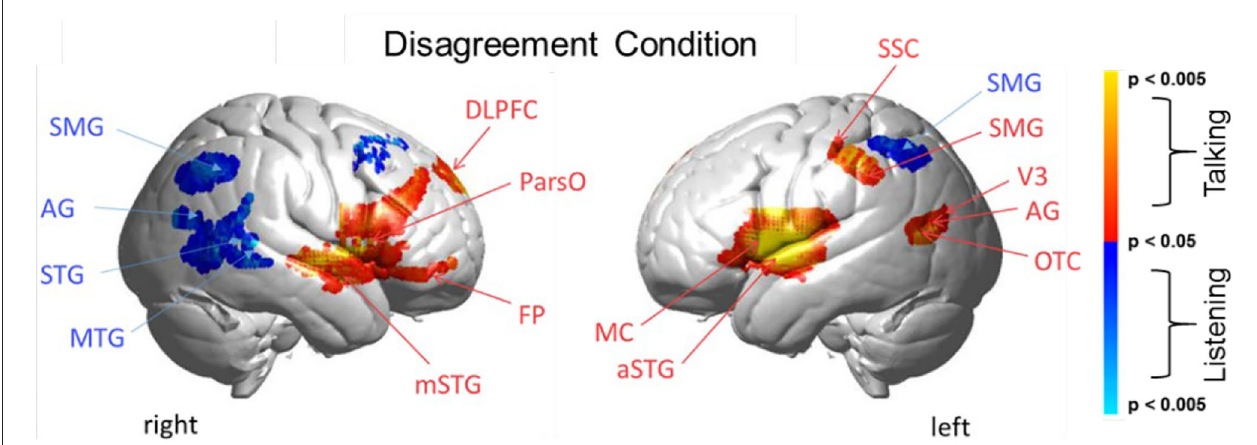
FIGURE 4 | Disagreement condition. Brain activity clusters represent functions of talking [talking > listening] (red) and listening [listening > talking] (blue). Talking (relative to listening) during disagreement with a partner engages the canonical language system including components of left hemisphere Wernicke’s Area (AG, angular gyrus; SMG, supramarginal gyrus); Broca’s Area (aSTG, anterior superior temporal gyrus; IFG, inferior Frontal gyrus); and components associated with the MC, motor cortex. These frontal systems are also observed bilaterally and include mSTG, middle superior temporal gyrus; ParsO, pars opercularis; DLPFC, dorsolateral prefrontal cortex; FP, frontopolar cortex. Listening during disagreement (blue) engages regions in the right TPJ, temporoparietal junction; AG, including angular gyrus; STG, superior temporal gyrus; MTG, middle temporal gyrus; SMG, bilateral supramarginal gyrus. See Table 3 .